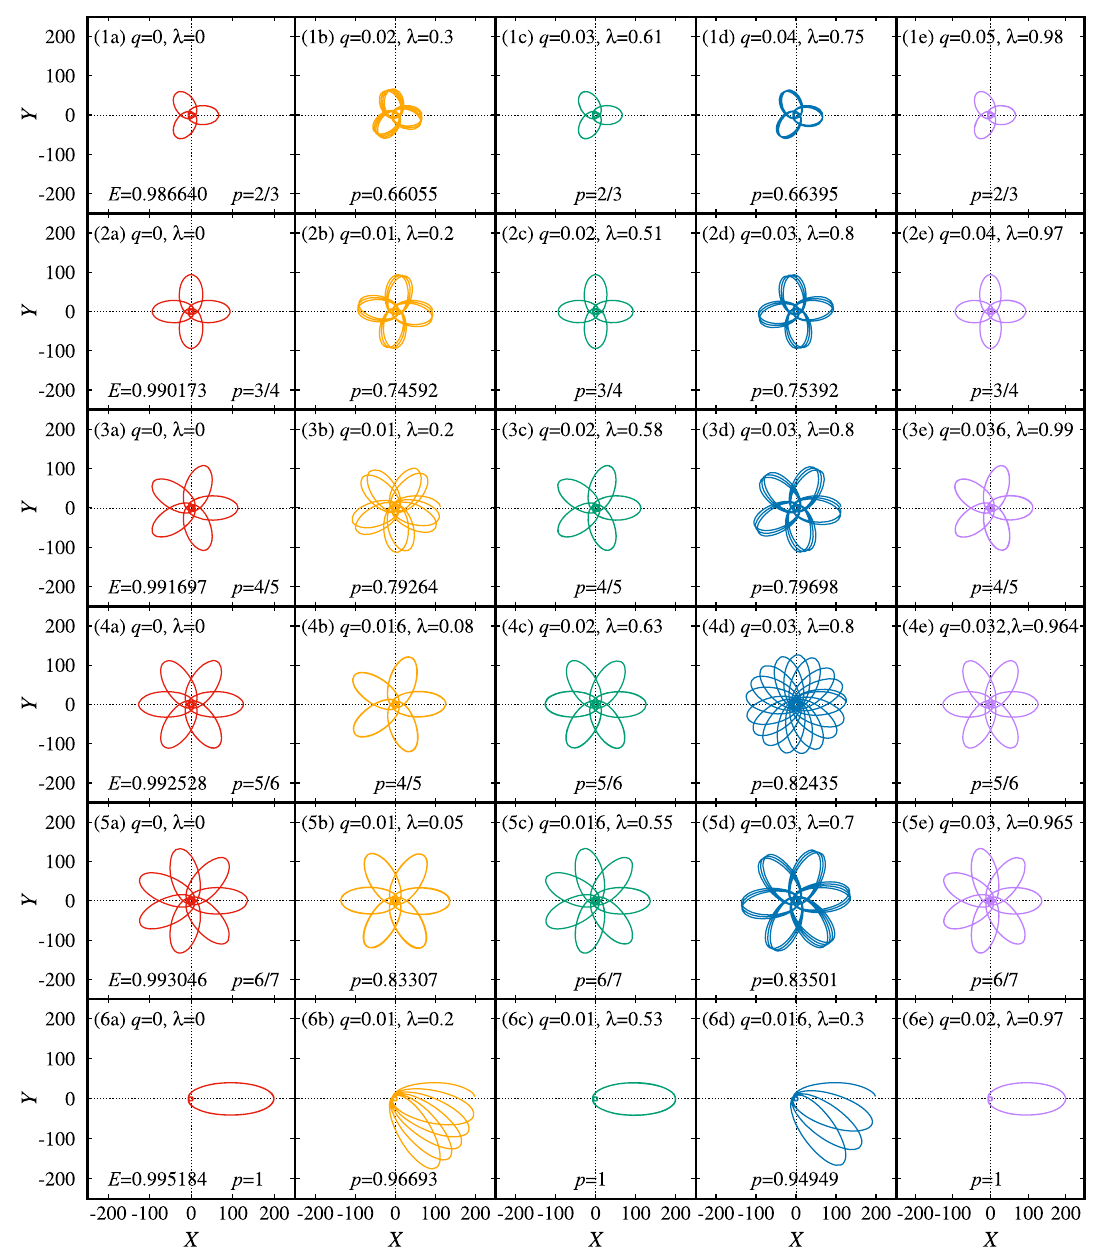
Fig. 5 Some examples of bound orbits around the black-bounce- Reissner–Nordström spacetime with l = 3 . 98, where ( X , Y ) is defined by Eq. (48) and the unique p is denoted in each panel. Each row shares